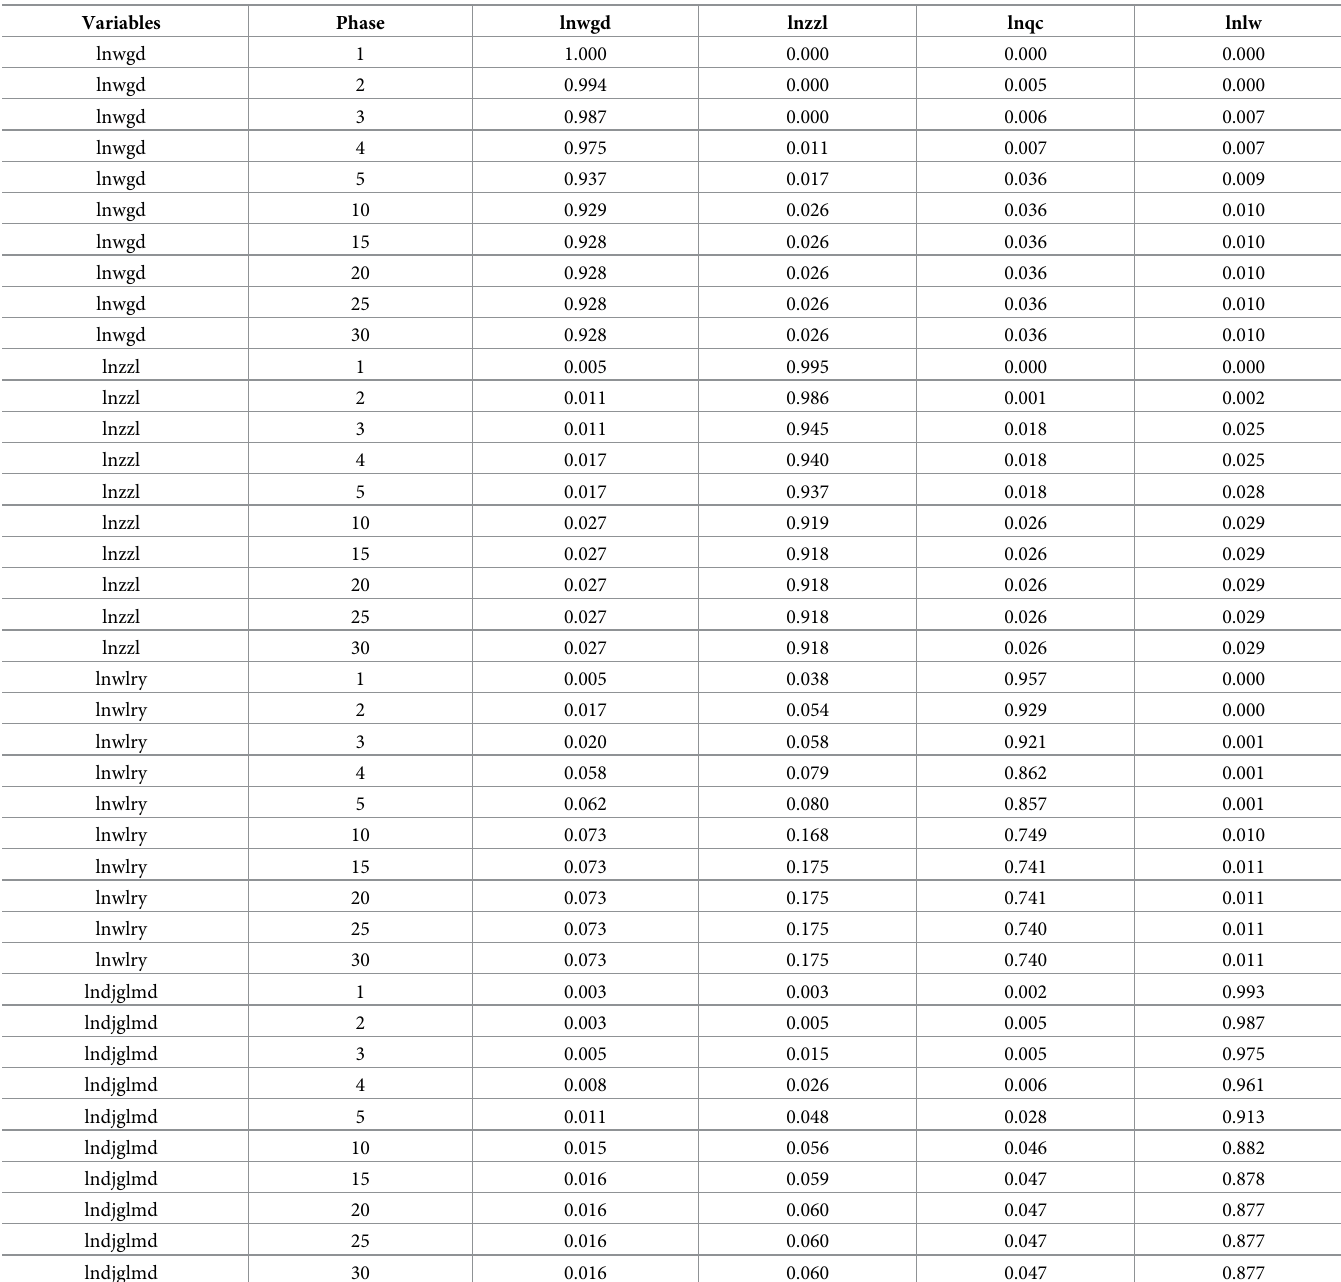
Table 24. Variance decomposition of logistics industry and the efficiency of two-industry-linkage.